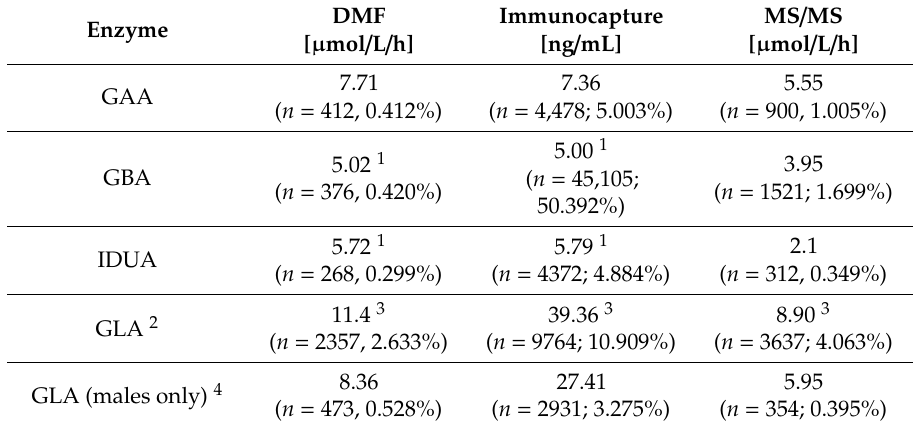
Table 2. First tier test cuto ff s and number of cases below the cuto ff s among the study population of 89,508 newborns (see Figure